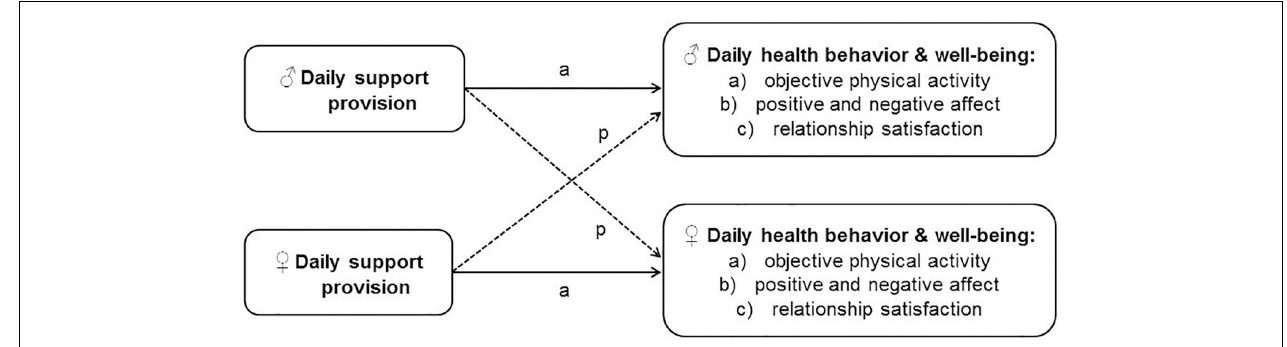
) and female ( ) couple members and ♂ ♀